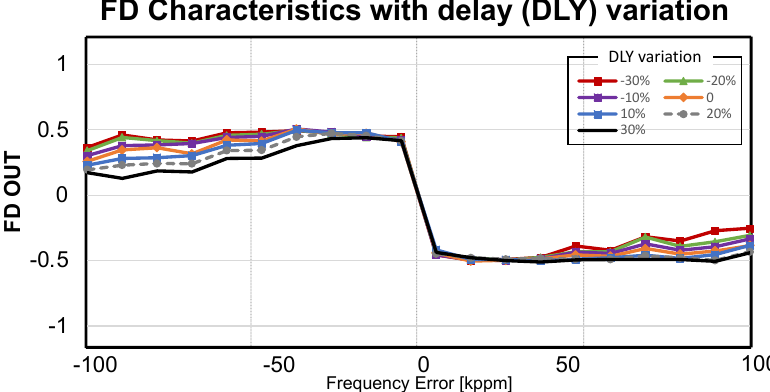
Figure 6. Characteristics of JT-DQFD depending on the timing mismatches in the input delay line @ 10